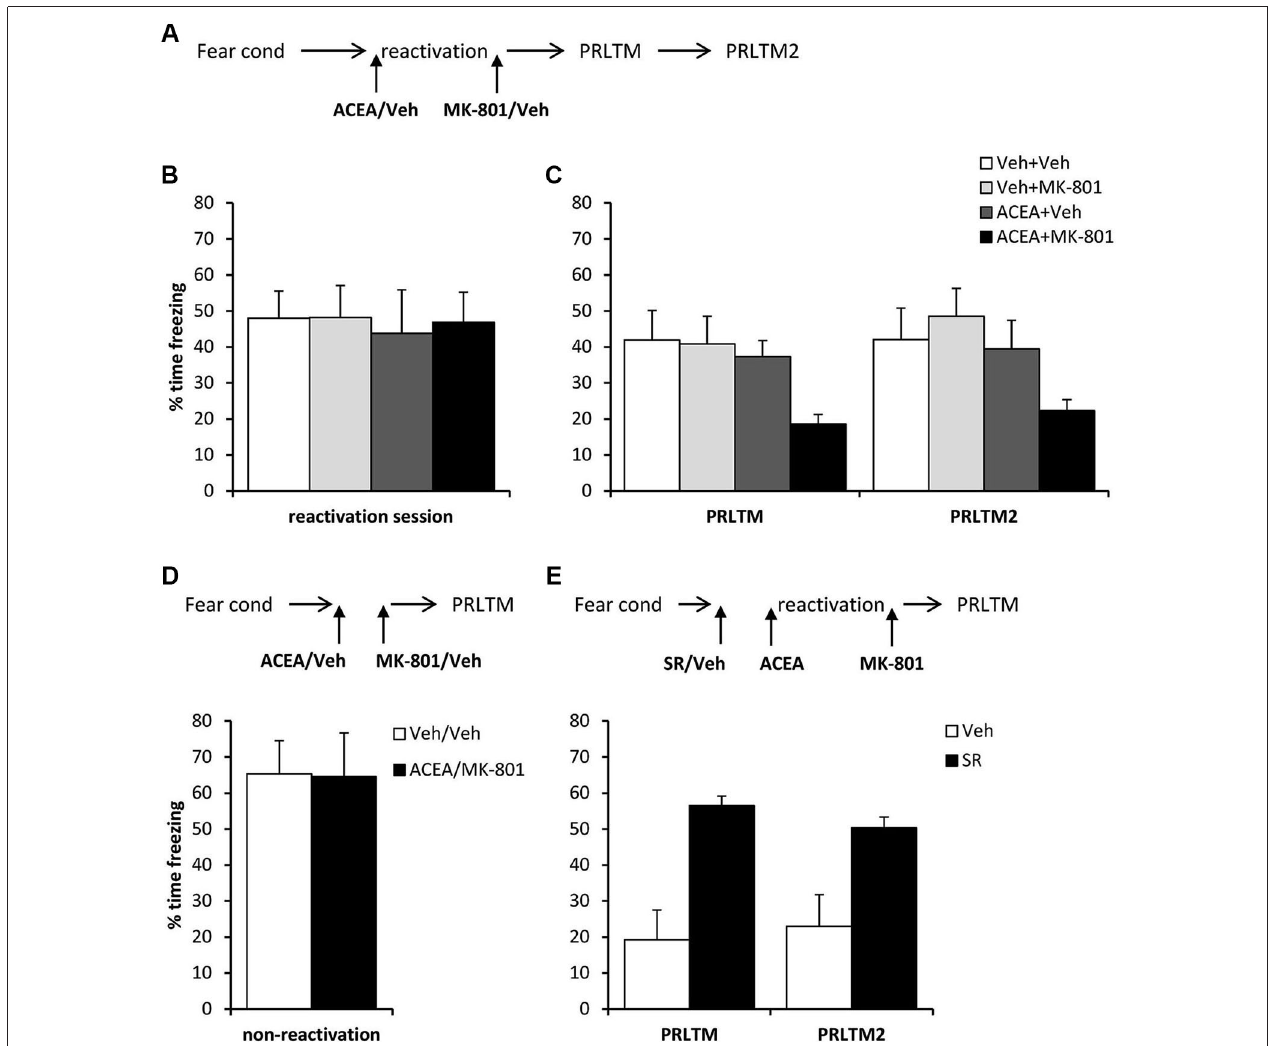
FIGURE 5 | Stimulation of memory destabilization by systemic ACEA injection . ( A ) Schematic representation of the experimental procedure for panels B and C. ( B ) Prior to injection, there were no pre-existing differences in contextual freezing at memory reactivation. ( C ) Injection of ACEA 5 min prior to the reactivation session, combined with immediate post-reactivation MK-801injection impaired memory reconsolidation. In contrast, injection